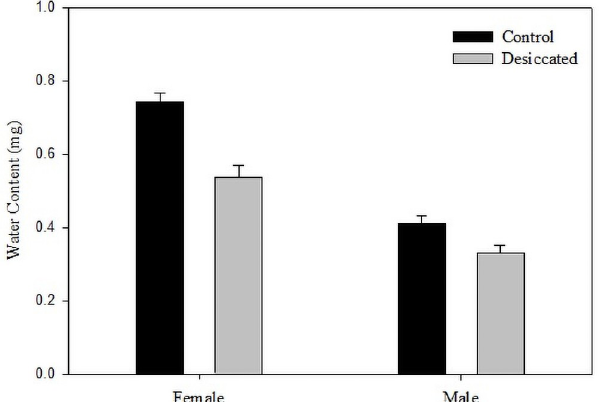
Fig 4. Water content measurement. Bar graphs depicting water content as measured in untreated flies, in comparison with desiccated flies (Treatment time = 7 hours 39 minutes). Each bar denotes the average value recorded for 180 flies (36 groups of 5) and the error bars represent values of standard